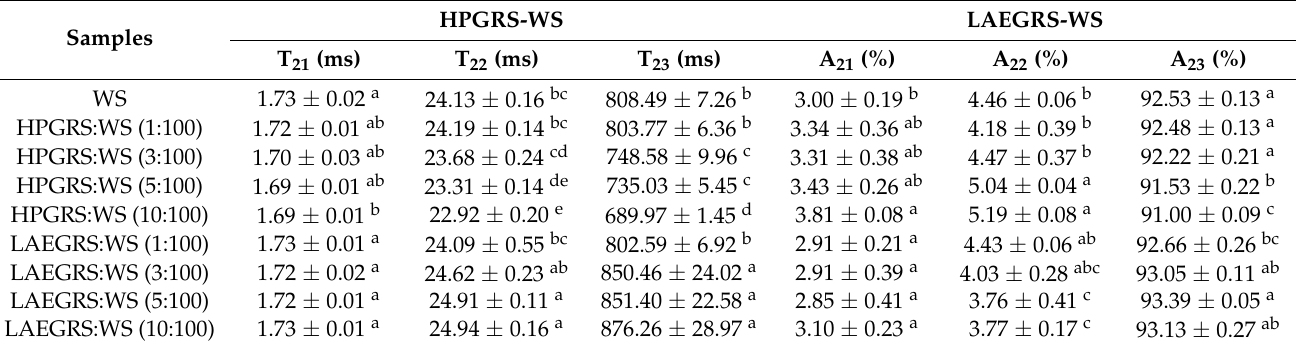
Table 3. T 2 relaxation distributions and factions of signal amplitude of protons of different proportions of HPGRS and LAEGRS (0%, 1%, 3%, 5%, and 10%) blended with WS